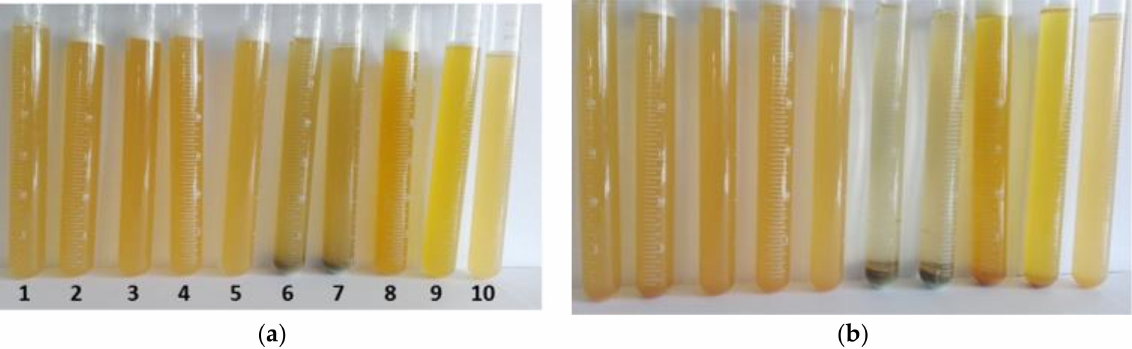
Figure 3. Coagulation process of flowback water with selected coagulants (1-ALS, 2-PAX18, 3-PAXXL10, 4-PAX 19F, 5-PAX19H, 6-SAX13, 7- SAX18, 8-PIX113, 9-PIX116, 10-flowback water as reference sample) after ( a ) 5 min ( b ) 60